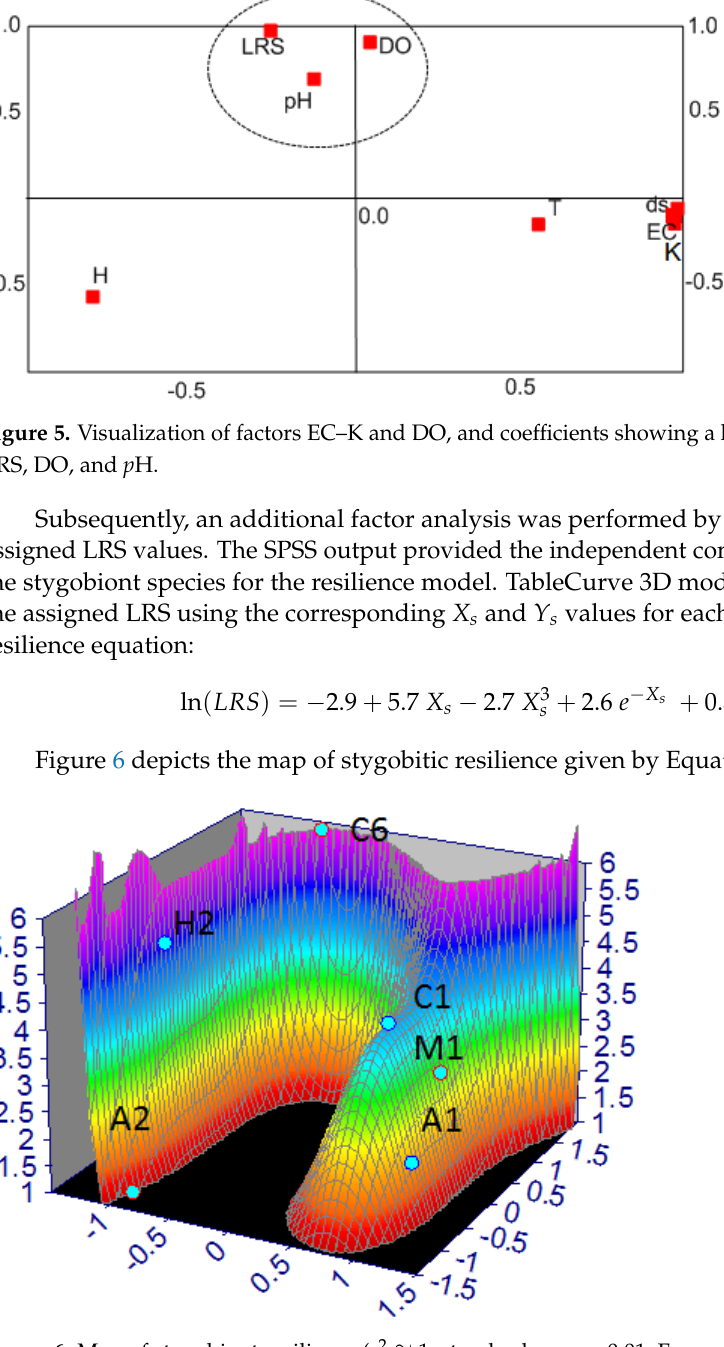
Figure 6. Map of stygobiont resilience (r 2 ∼ = 1; standard error = 0.01; F stat = 2.6 × 10 4 ) sampled from Murgia and Salento groundwater